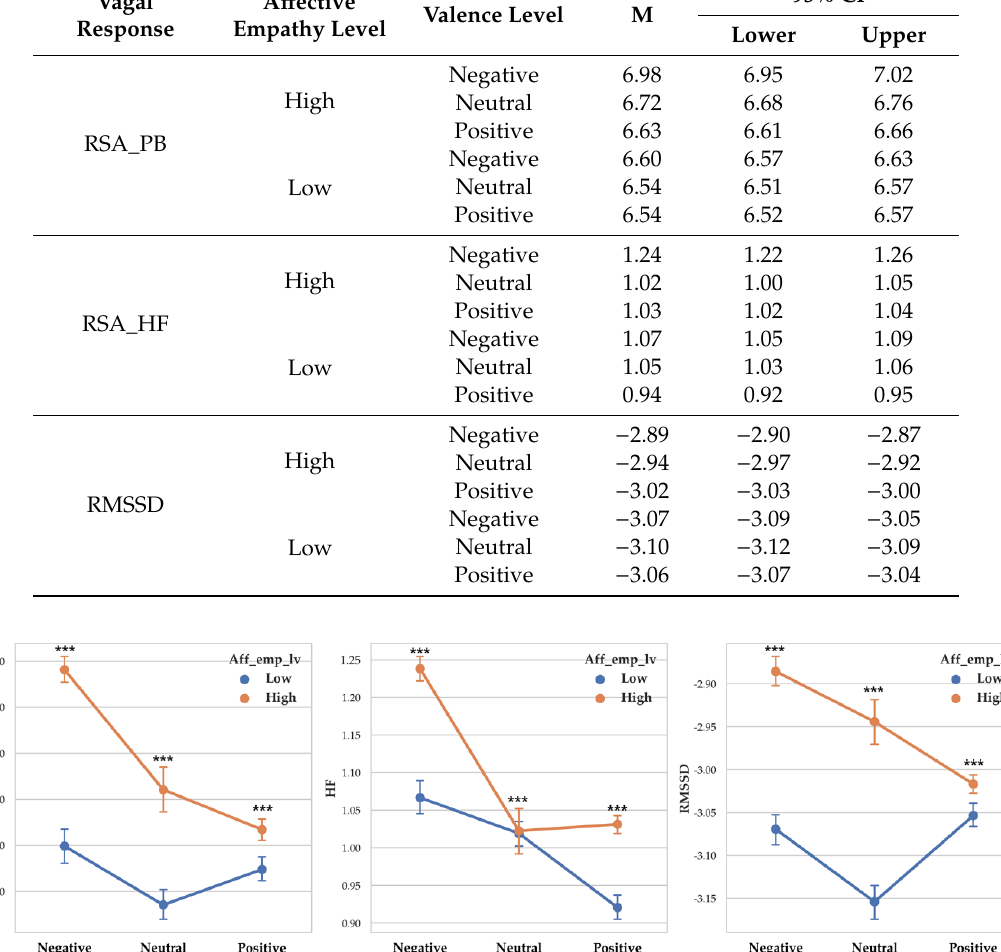
Figure 6. Point graph of vagal response depending on affective empathy level when participant empathized with valence levels. Aff_emp_lv refers to affective empathy level. Point means mean of vagal responses and error bars represent confidence interval. Asterisk means significant vagal responses difference according to affective empathy level. (***: p < 0.001.).